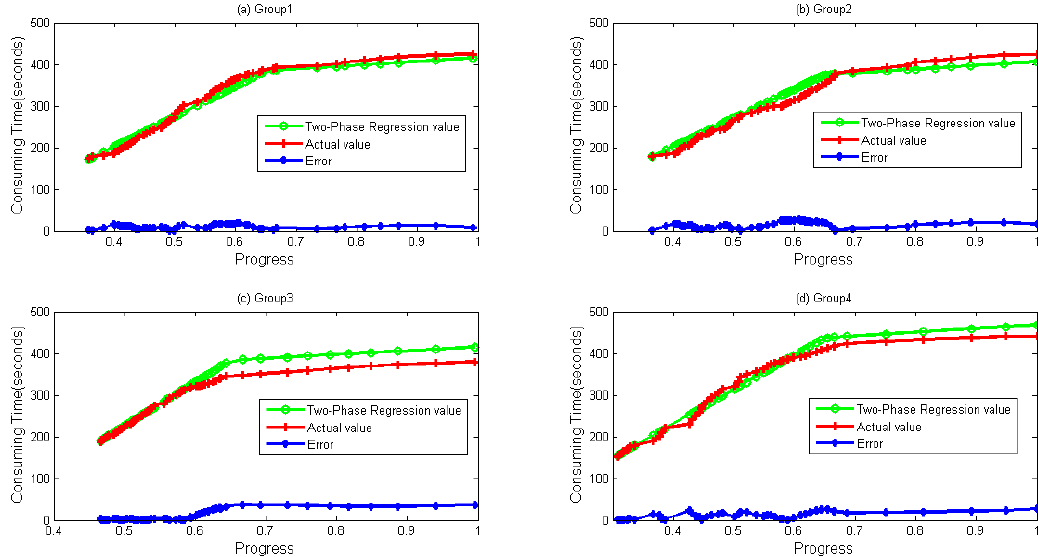
Figure 8. Two-Phase Regression values. Error obtained by Abs (Regression Value – Actual value). ( a ) Group 1; ( b ) Group 2; ( c ) Group 3; and ( d ) Group 4 data and their values calculated by Two-Phase Regression for Sort sample.